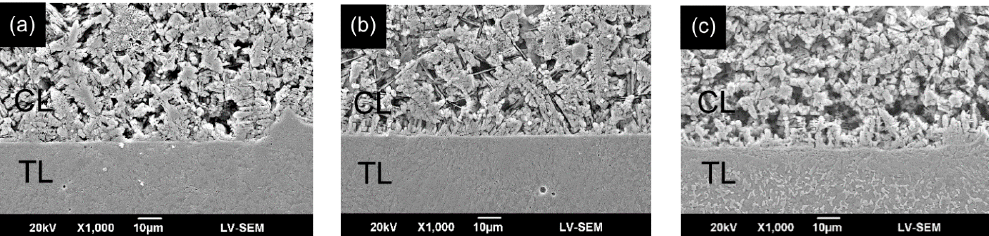
Figure 6. SEM metallographs of CL/TL interface in FA/ZrO 2 laser-clad specimens: ( a ) 400 W, 200 mm/min; ( b ) 800 W, 400 mm/min; and ( c ) 1200 W, 600 mm/min.